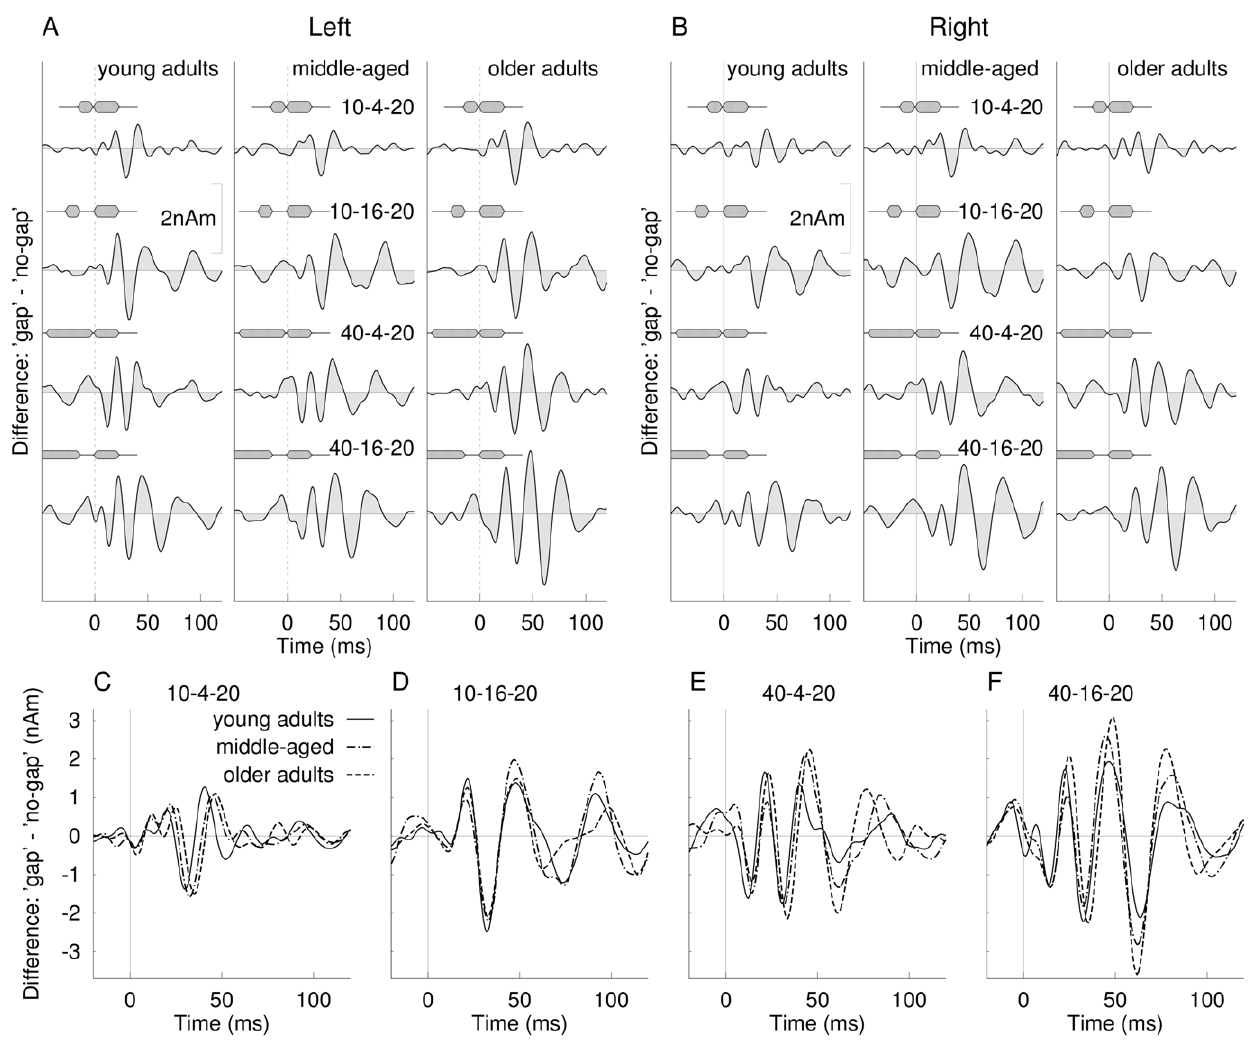
Figure 6. Difference waves between gap and no-gap stimuli for the transient 40-Hz response, the three age groups, and four different stimuli. Time zero of all time scales is adjusted to the onset of the trailing marker. A : Difference waves observed in the left and B : in the right hemisphere. C–F : Overlay of difference waves observed in the three age groups averaged across left and right hemispheres.